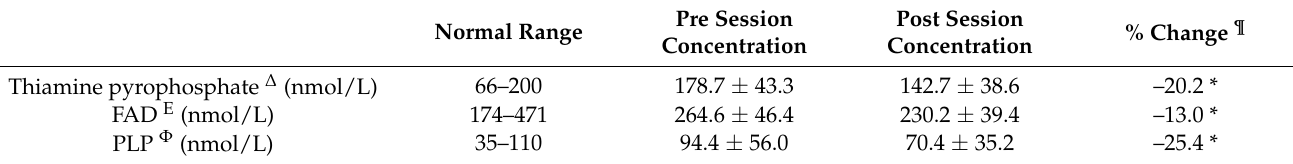
Table 2. Vitamins and trace elements blood concentration before and after one hemodialysis